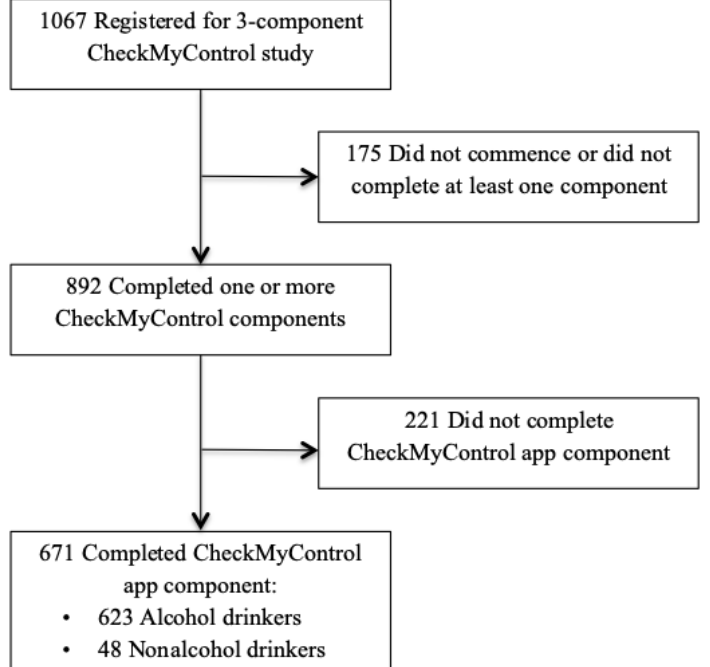
Figure 2. Flow diagram following Consolidated Standards of Reporting Trials guidelines of study